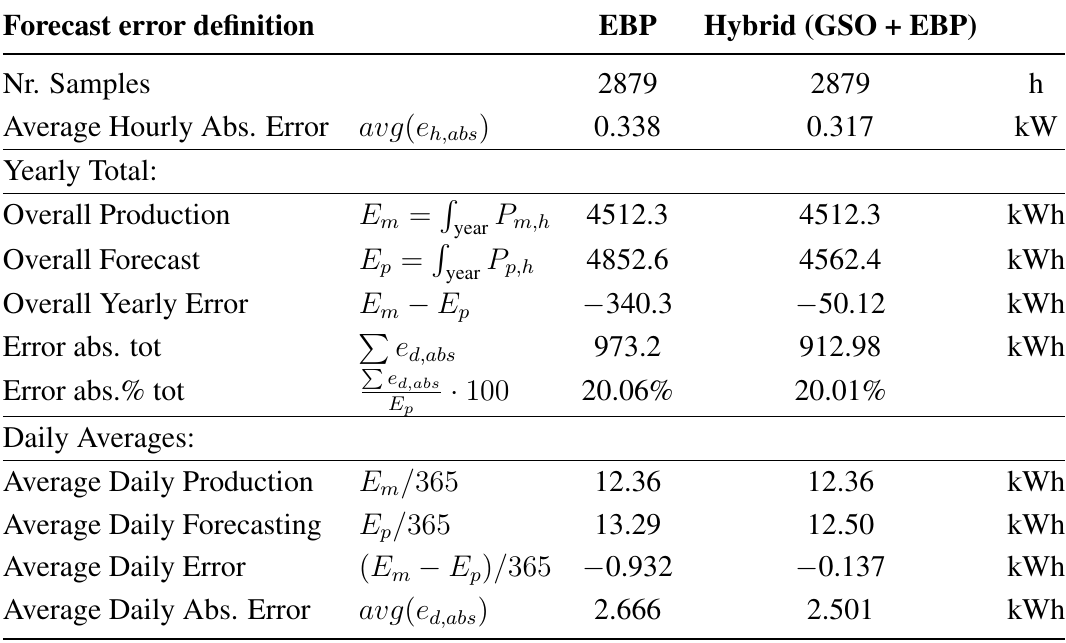
Table 2. Main production data and error calculation with reference to the entire